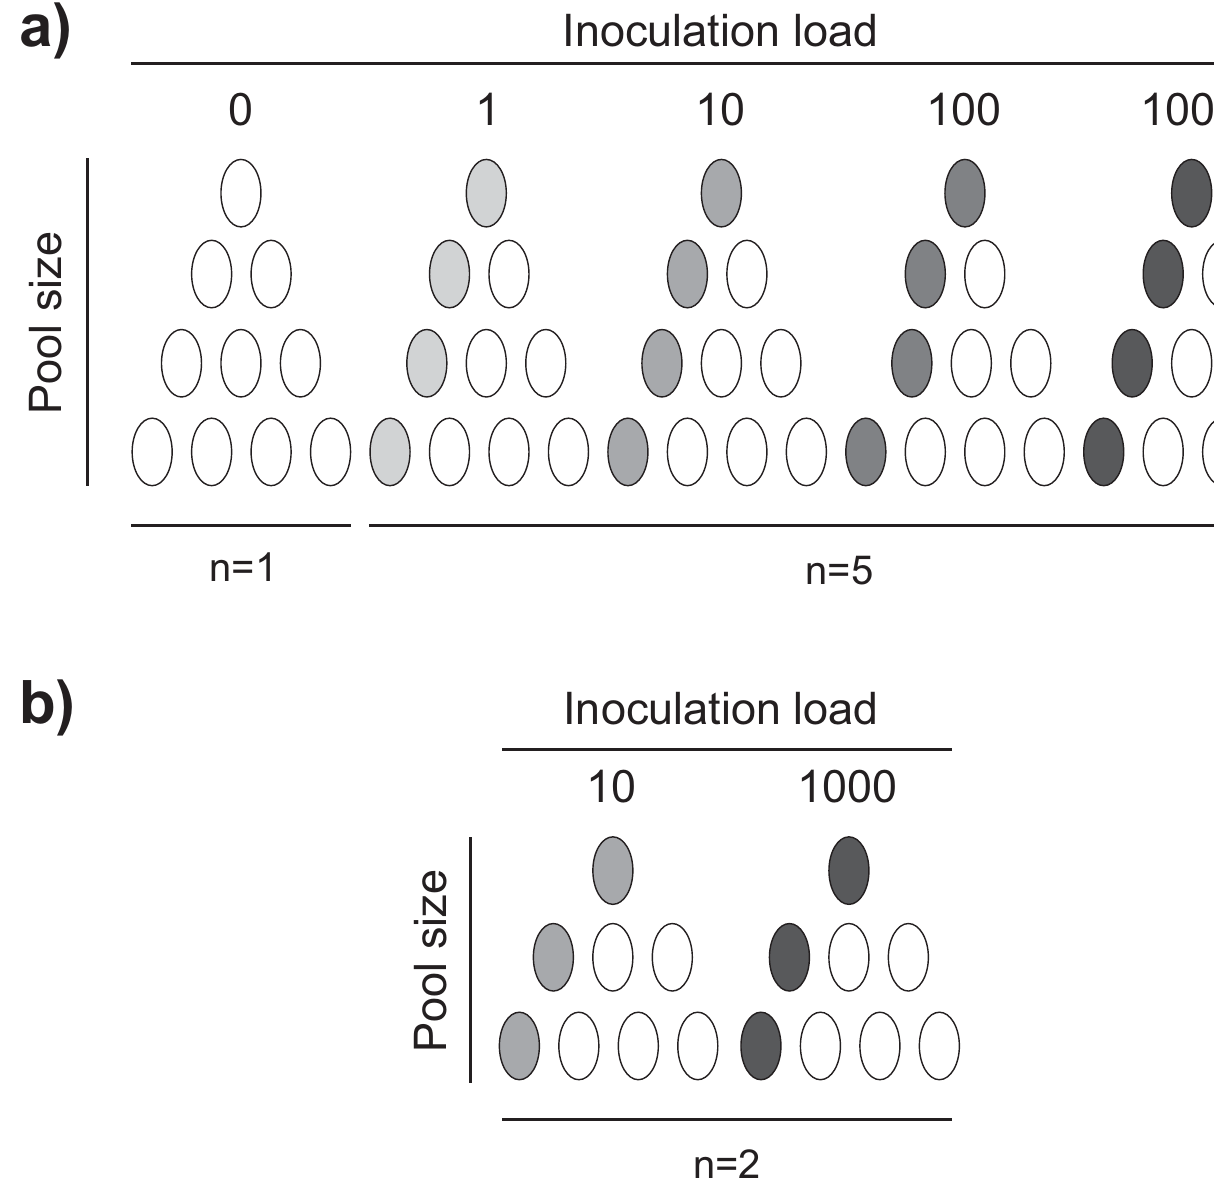
Fig 1. Experimental set up. Experimental set up for pooled extraction of: a) Experiment 1, for Salamandra salamandra ; and b) Experiment 2, for Alytes obstetricans , Cynops pyrrhogaster , Ichthyosaura alpestris , Lissotriton helveticus , Pachyhynobius shangchengensis , and Tylototriton wenxianensis . Swabs were pooled in groups of one to four swabs (pool size) with one swab per pool being inoculated with zoospores (inoculation load) (with the exception of the controls). Load in zoospores per